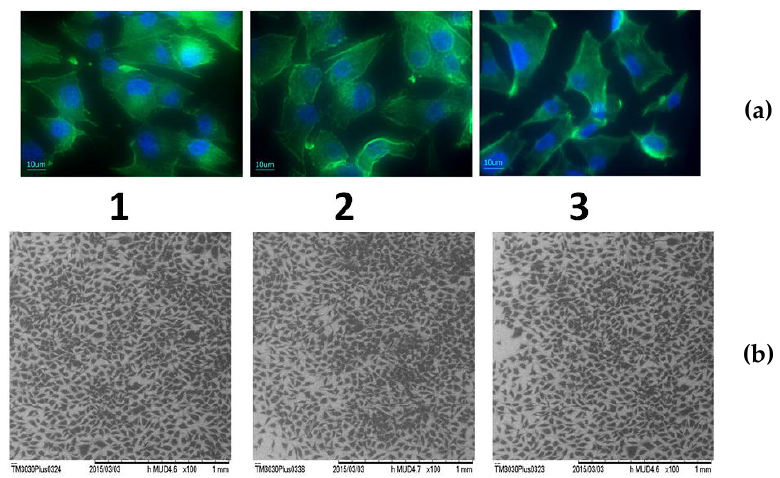
Figure 9. Cell viability of the samples measured after 3 ( a ) and 5 ( b ) days of culture.